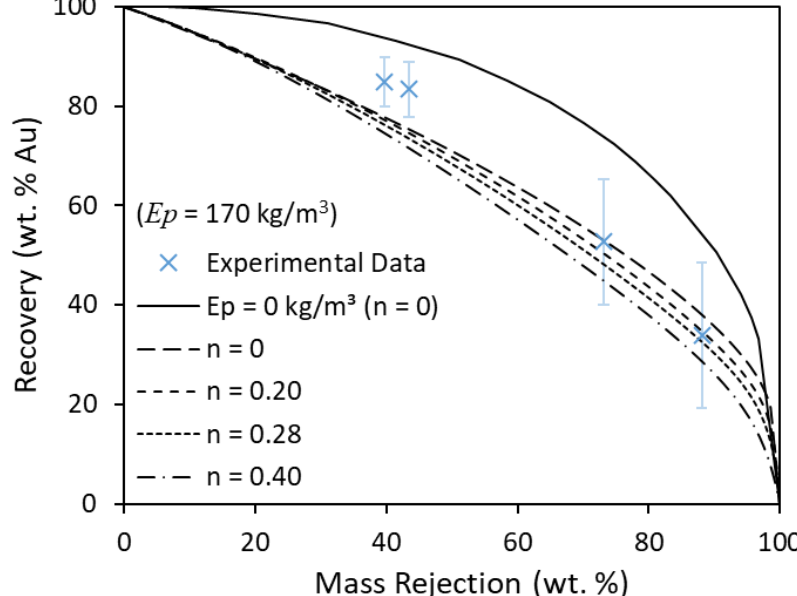
Figure 11. Recovery modelled as a function of mass rejection for varying n values using Ep = 170 kg/m 3 . The model predictions are compared to the experimental data [22].